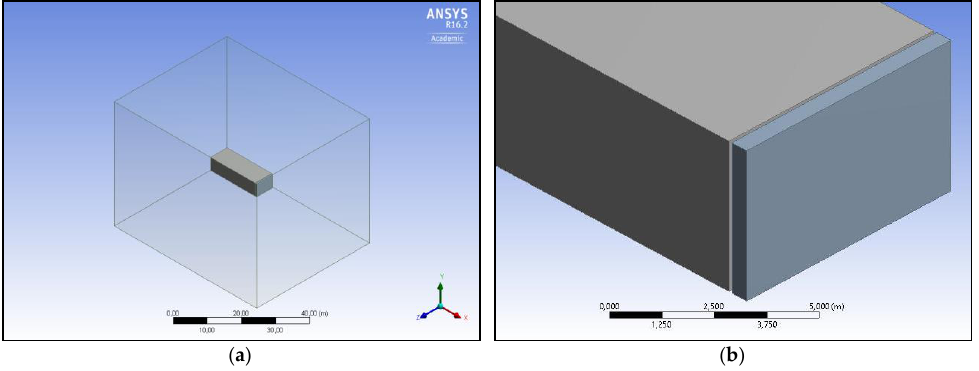
Figure 1. Geometry used for the simulation: ( a ) The entire domain considered for the analysis, consisting of a fluid domain of the furnace enclosed in another fluid domain which represents the ambient air; ( b ) Particular of the geometry where the fluid domain of the furnace is shown in grey, while the door is showed in blue.